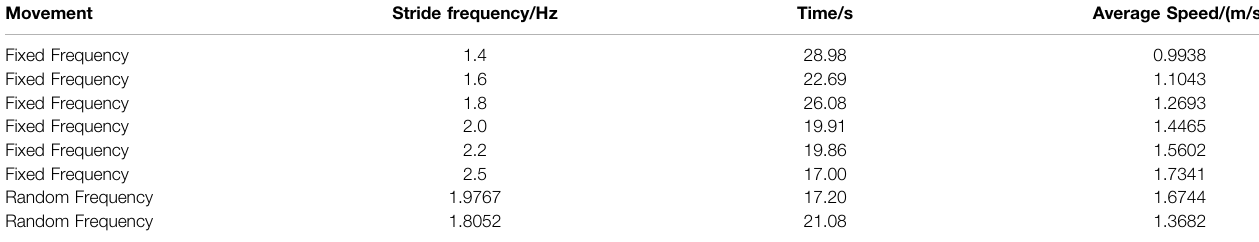
TABLE 5 | Experimental data of tester 2 walking at different step frequencies. Movement